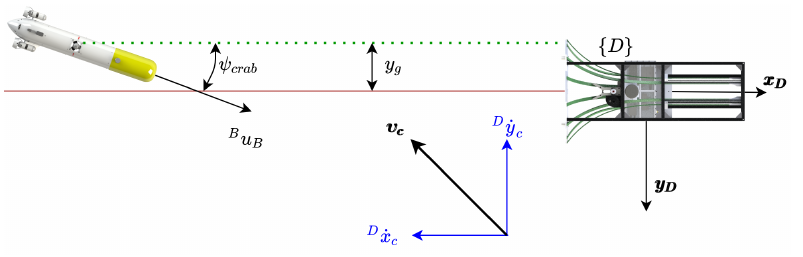
Figure 6. Path concept representation.